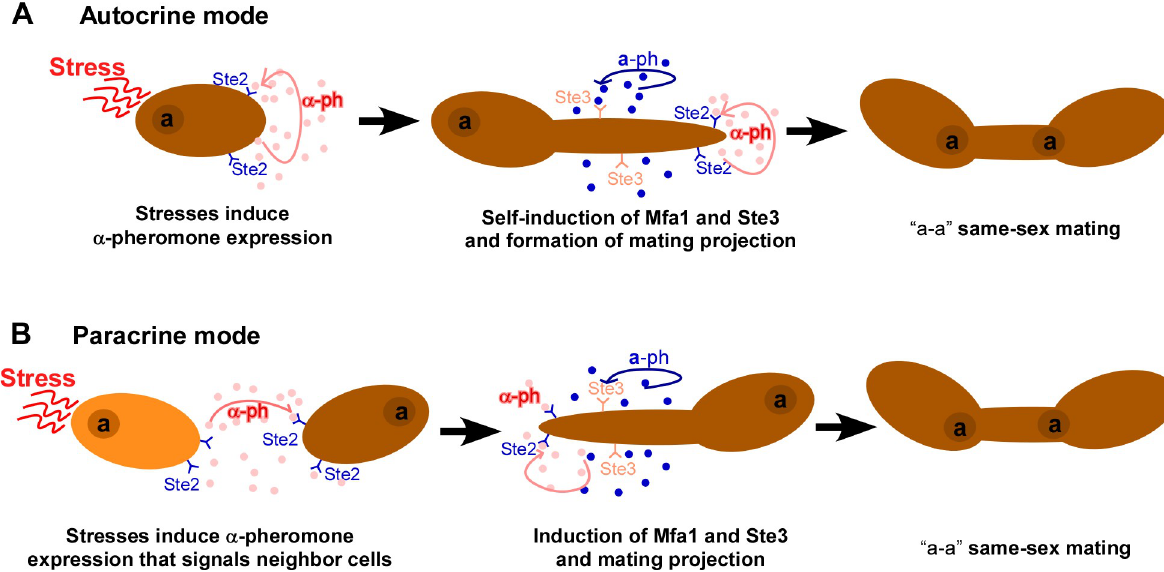
Fig 9. Potential autocrine (A) and paracrine (B) pheromone response models for stress-induced mating-projection formation and same-sex mating. Neither α -pheromone nor a -pheromone is constitutively expressed in “ a ” cells of C . albicans . Glucose starvation or oxidative stress first induces α -pheromone and its receptor Ste2 expression in “ a ” cells. α -pheromone binds to Ste2 and activates the pheromone-response pathway, which subsequently induces the expression of a -pheromone. “ a ” cells then become mating competent as both “ a ” and “ α ” types. The activation of the pheromone-response pathway promotes mating projection formation and same-sex mating. Autocrine pheromone response, self-activation (A); paracrine pheromone response, activation of neighbor cells (B). MFA1 , Mating type A1; STE2 , STErile 2.